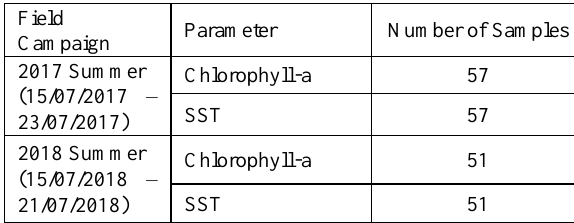
Table 1. Dates of field campaigns of MAREM (Artüz et al.,